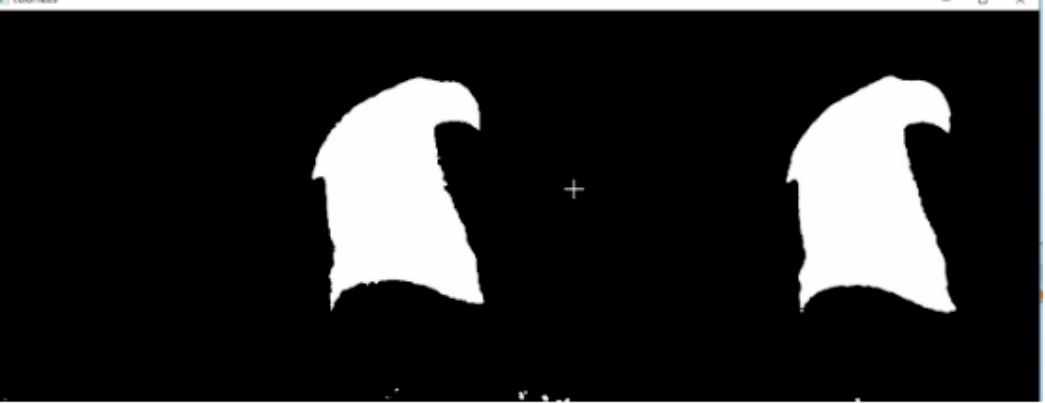
Figure 13. Image after threshold in HSV.